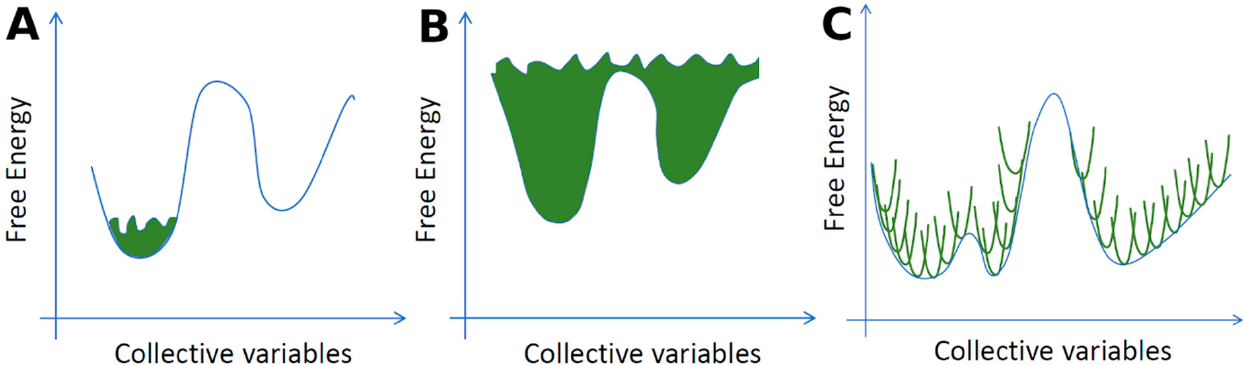
Figure 9. Collective variable-based enhanced-sampling methods restrain the system along one or more reaction coordinates (so-called collective variables) by introducing an additional bias potential. ( A , B ) Metadynamics [277]. ( A ) After the simulation has reached a local minimum and is sampling around it, a biased potential is employed to enhance the sampling in that part of the potential energy surface to be able to push the system away from the local minimum to new regions. ( B ) In the end, the biased potential becomes larger than the free energy barriers, allowing the system to move freely from one minimum to the other. ( C ) Umbrella sampling [200]. The reaction coordinate is divided into separate overlapping windows and the biasing potential is applied to each window to efficiently sample the conformational space by multiple simulations along the reaction profile.